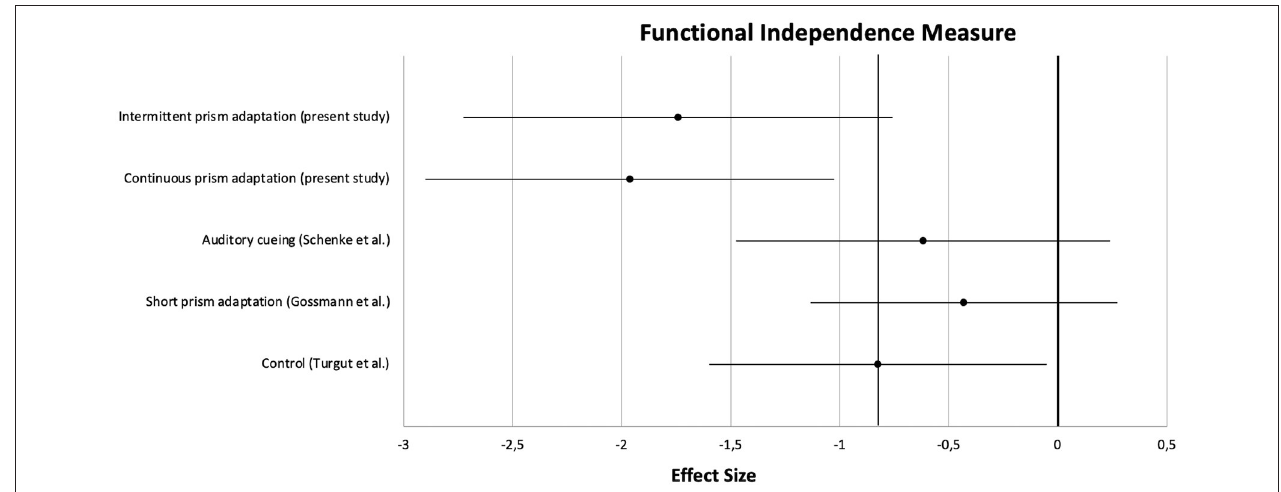
FIGURE 6 | Comparison of effect sizes of the present prism adaptation treatment protocols and previous studies on neglect interventions for the Functional Independence